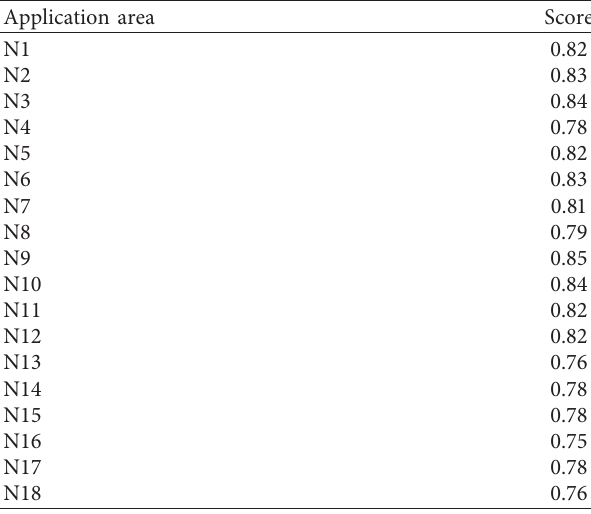
Table 4: Analysis of variance of different types of respondents. Table 5: The weighted average scores of BIM application